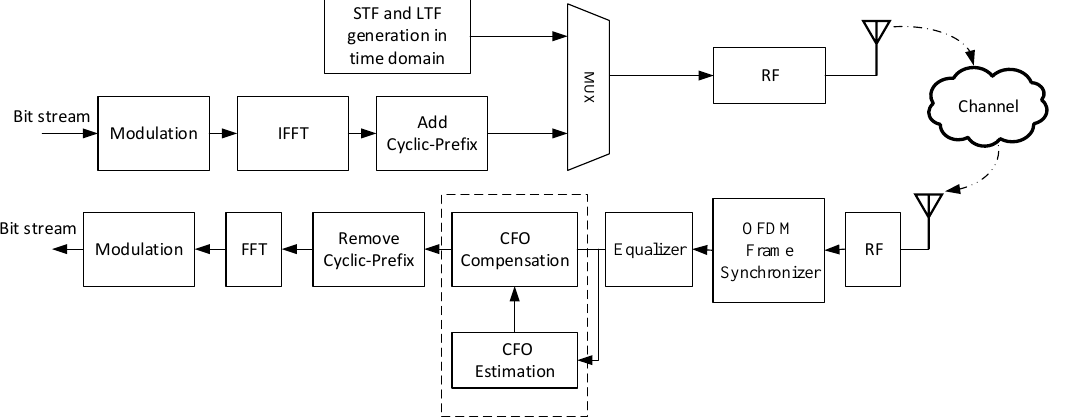
Figure 3. Block diagram of the architecture of the proposed scheme .